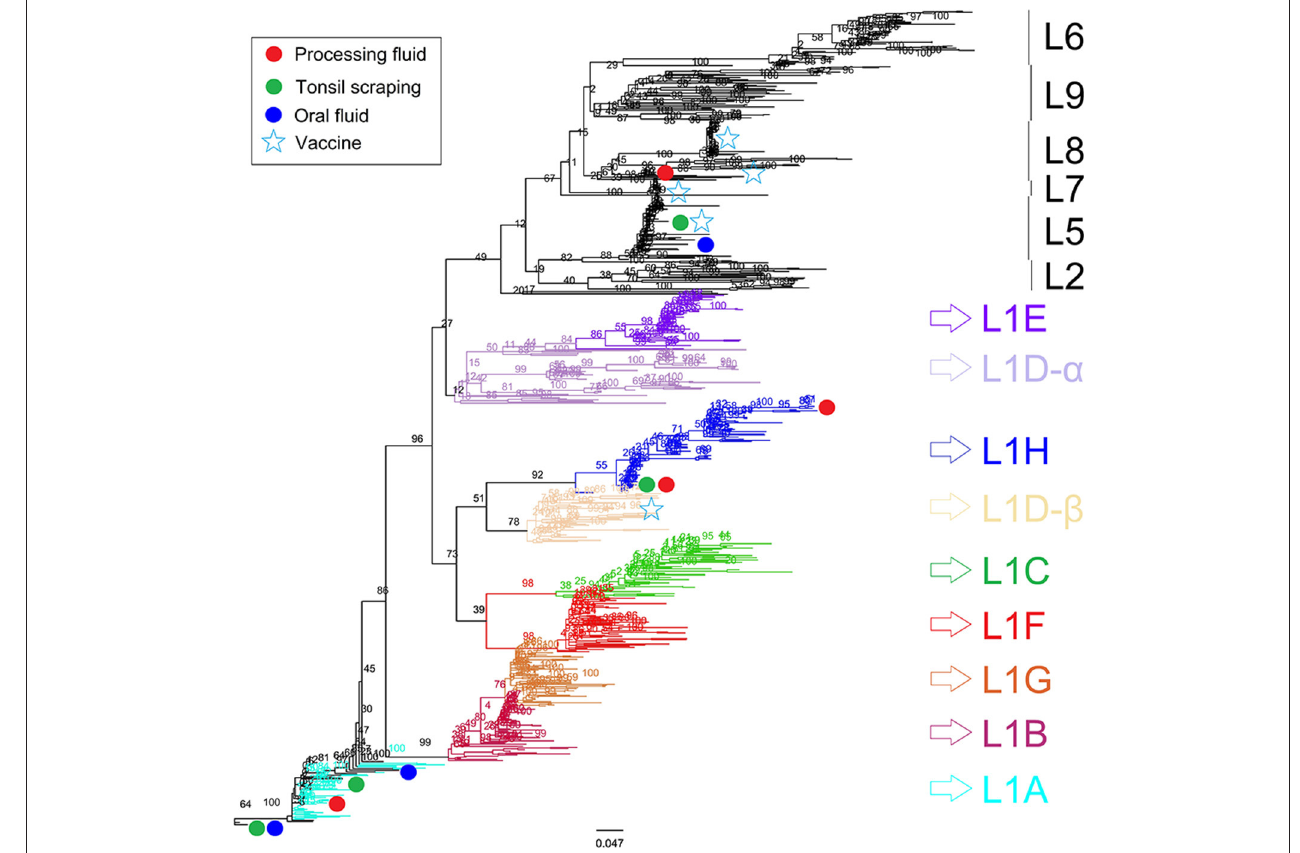
FIGURE 2 | Porcine reproductive and respiratory syndrome virus (PRRSV) ORF5 phylogenetic consensus tree constructed using the maximum likelihood method with bootstrap resampling. Sequences from processing fluids ( n = 34) of three breeding farms (Farm 1, 2, and 3), oral fluids ( n = 7) of two growing farms (Farm 4 and 5), tonsil scraping ( n = 12) of all recruited farms (Farms 1–5), 690 previously reported lineage anchors, and five PRRSV vaccine strains, were classified and compared. Sequences that are highly clustered are labeled only once due to the space